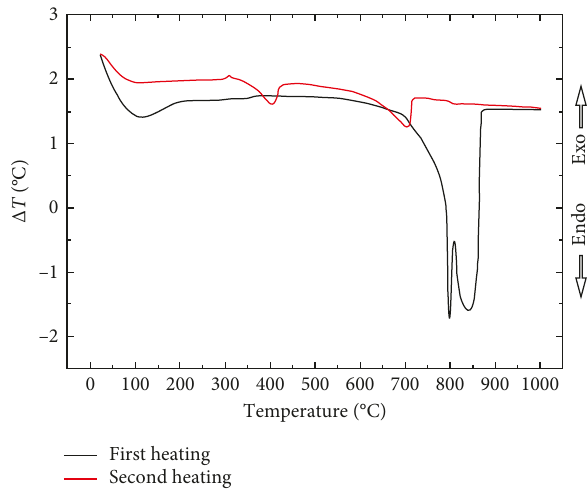
Figure 4: Comparison of DTA heating curves of sample